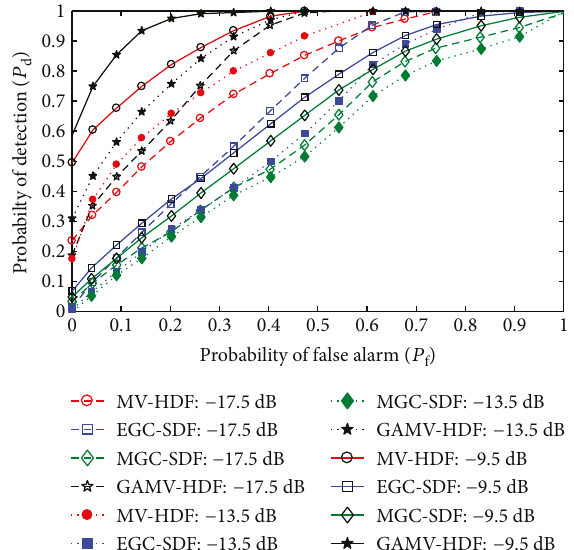
Figure 5: Probability of detection versus probability of false alarm at di ff erent SNR values with MUs having high SNR compared with NSUs.